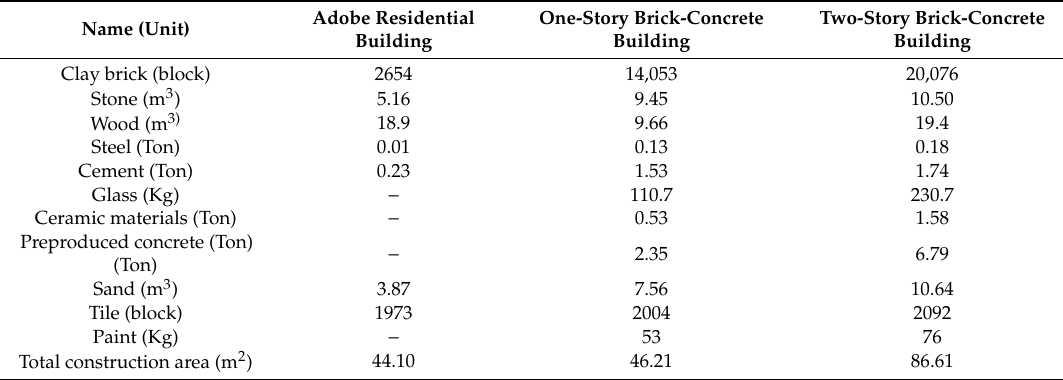
Table 3. List of building materials in di ff erent residential buildings.